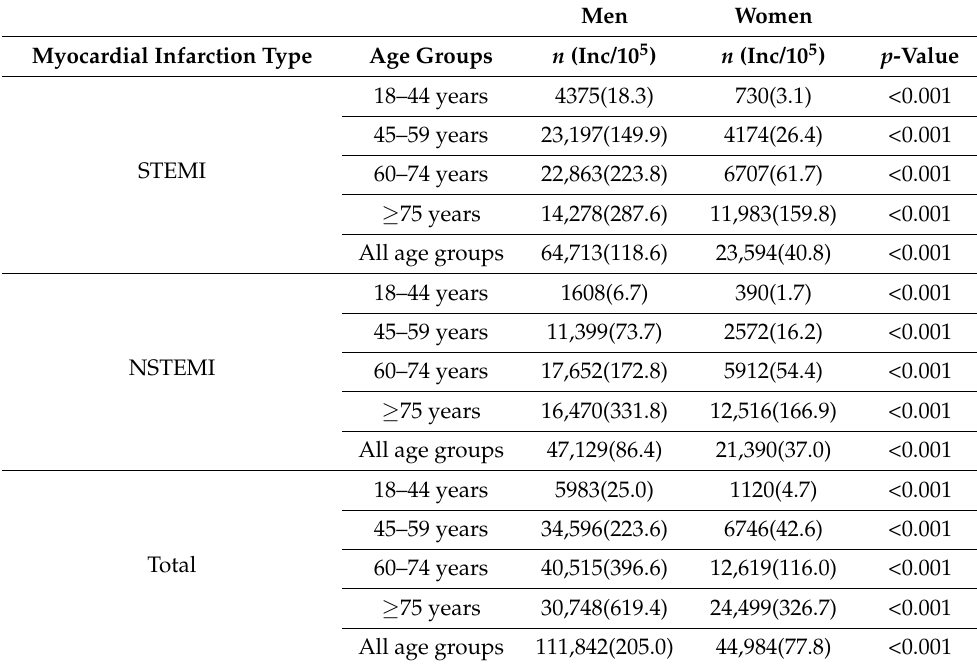
Table 1. Incidence rates of hospital admission with a primary diagnosis of myocardial infarction, with and without ST segment elevation, according to sex and age group in Spain